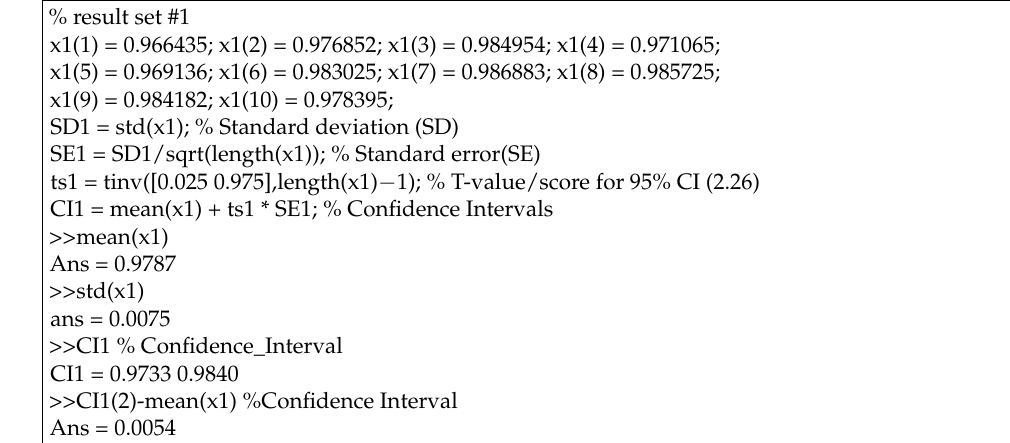
Figure 16. Data graph of the CNN cost function evolution vs. number of epochs in C4D2a_4C. The MATLAB code for a sample mean of in C4D2a_4C data and its confidence interval, when the sample size n = 10 is, as follows (Box 5). Box 5. The MATLAB code for a sample mean of in C4D2a_4C data.